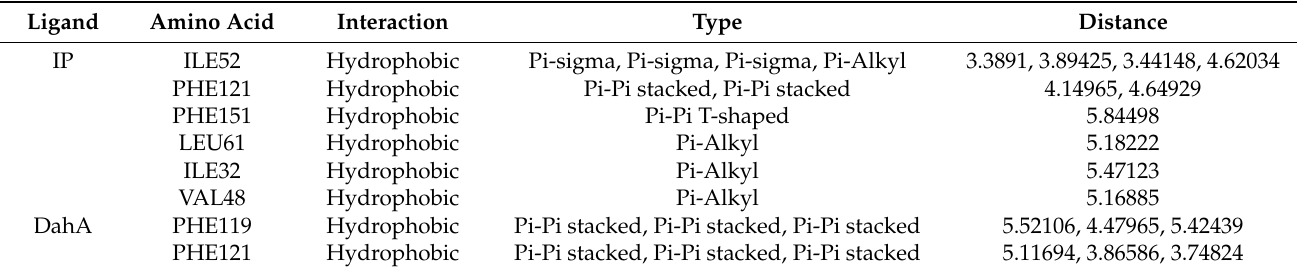
Table 4. Distance of interaction between ligand and TLR4 amino acids.